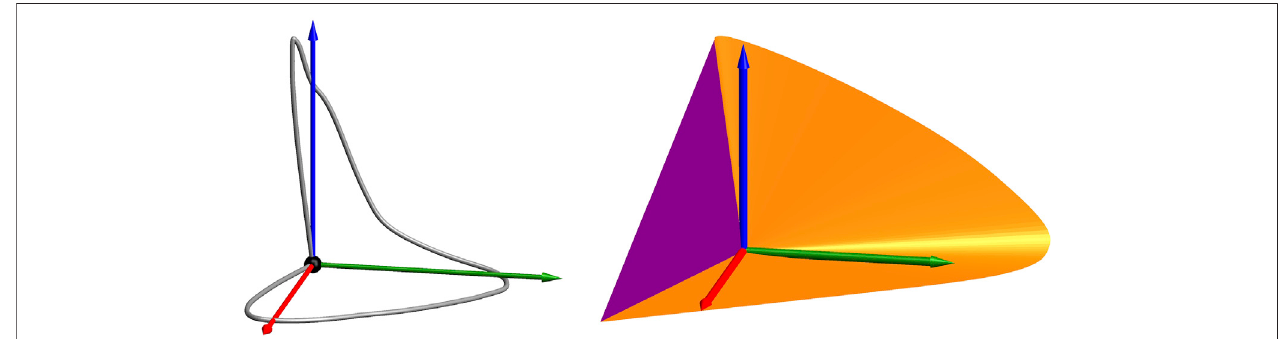
FIGURE 1 | At left the curve of the RGB -colors of unit energy monochromatic beams. All realizable colors (for any radiant power of the source) lie within the convex hull of the lines through the origin and this curve. The surface of the “ spectrum cone ” in C RGB ( Section 4.3 ) fails to exhaust the boundary of the convex hull, so one introduces the “ plane of purples ” to close it (right) . Here the generators of the cone were clipped by the unit plane R + G + B (cid:2) 1 (conventionally used as “ chromaticity plane ” , used in Section 5